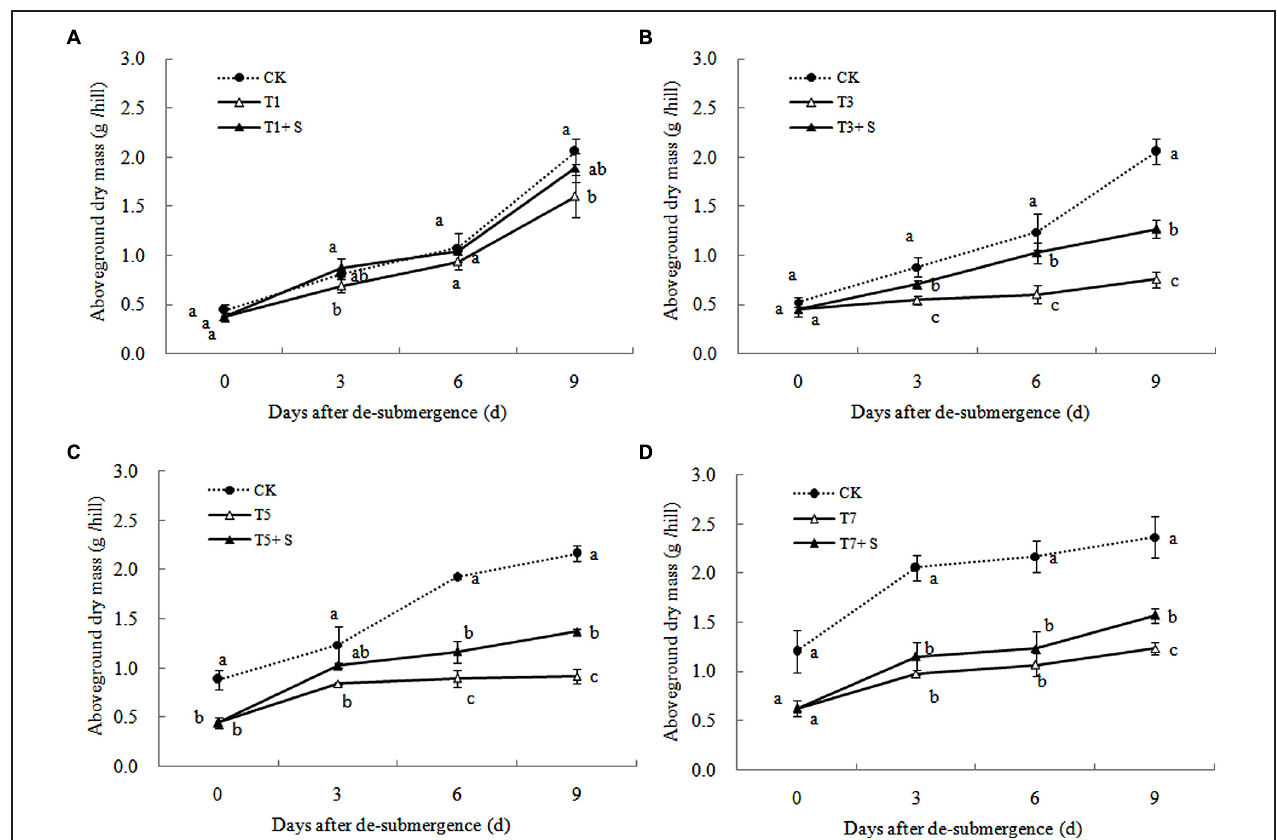
FIGURE 3 | Effects of Spd on shoot dry weight per hill of rice after submergence.